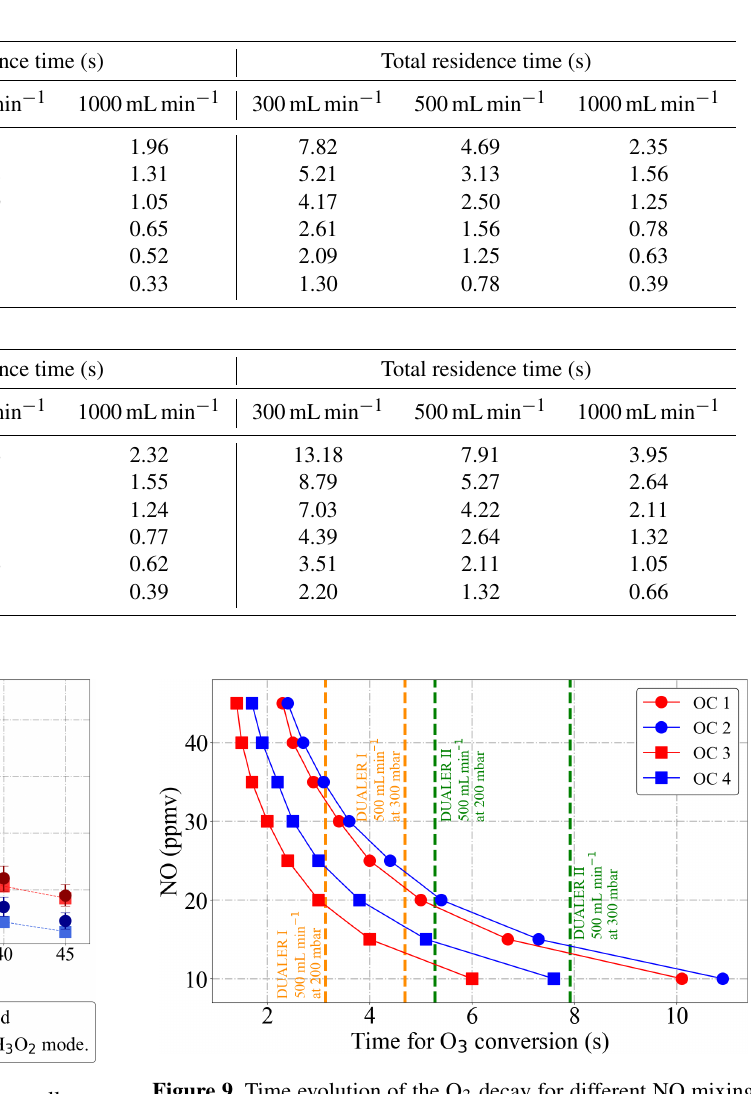
Figure 9. Time evolution of the O 3 decay for different NO mixing Figure 8. PeRCEAS eCL values retrieved experimentally at ratios added at the PeRCEAS reactors as simulated by a box model 300mbar for HO 2 (red circles) and a 1 : 1 HO 2 : CH 3 O 2 radical for 200 and 300mbar. OC1: 100ppbv O 3 at 200mbar inlet pressure; mixture (blue circles) for different NO mixing ratios in DUALER OC2: 200ppbv O 3 at 200mbar inlet pressure; OC3: 100ppbv O 3 at II. Modelled eCL values obtained for the same conditions are also 300mbar inlet pressure; OC4: 200ppbv O 3 at 300mbar inlet pres- depicted for comparison. The simulations use calculated values of sure. The sample residence times for 500mLmin − 1 sample flow in = 0 . 97 and k w = 0 . 74s − 1 , and assume 64% HO k w 2 and HO2 CH3O2 the DUALER I and II are also depicted for 54% CH 3 O 2 radical losses in the pre-chamber.